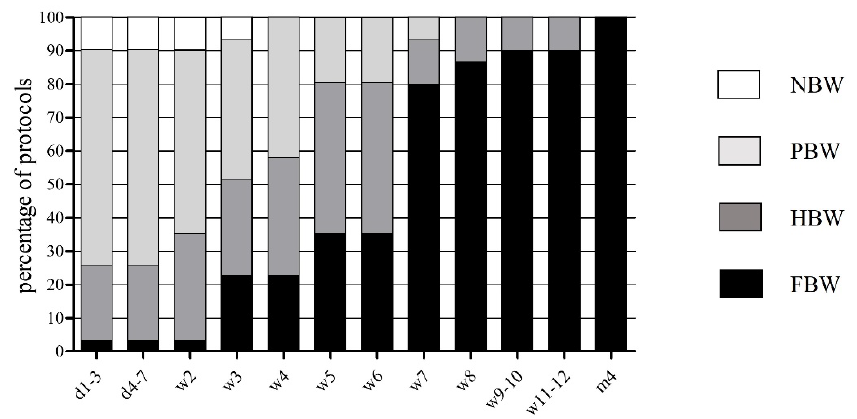
Figure 1. Early rehabilitation phase after PCL-R concerning weight bearing, expressed in percentage of protocols (%). NBW: no body weight, PBW: partial body weight, HBW: half body weight, FBW: full body weight, d: day, w: week.